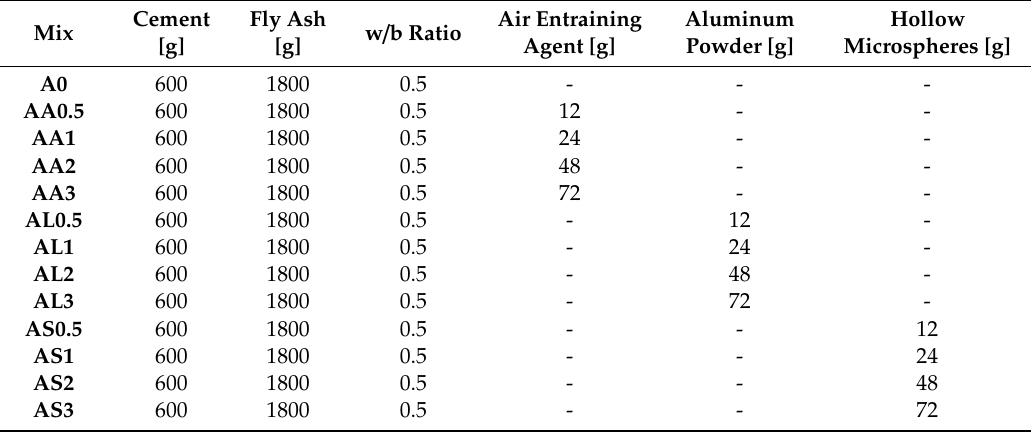
Table 2. Mix compositions of the used cement paste